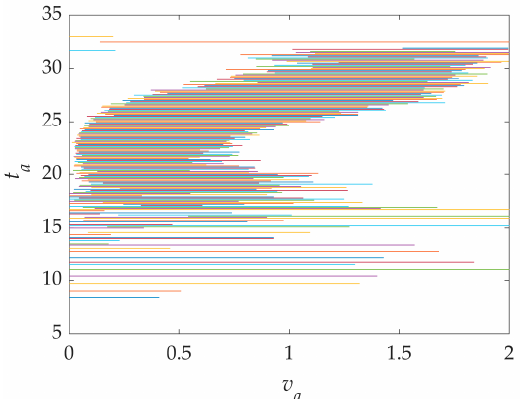
Figure 13. Average interval based on the mean of the left and right endpoint values of air velocity for all air-velocity adjustable intervals. (The color line represents the air velocity adjustment range of each temperature)